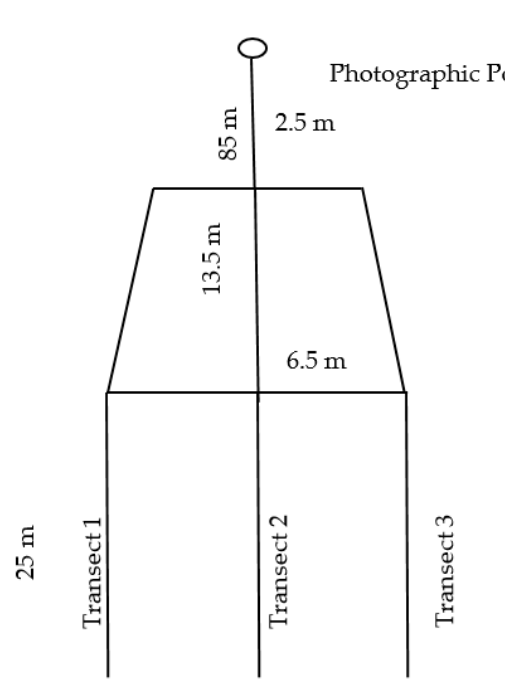
Figure 1. Long-term monitoring transects.